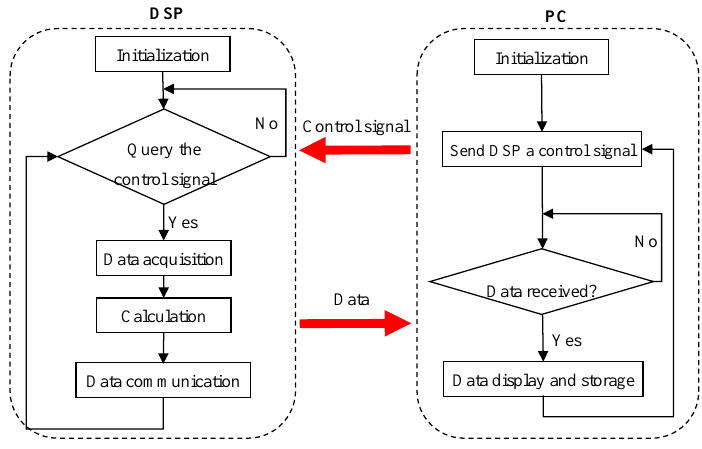
Figure 5. Flow chart of the software of the measurement system.